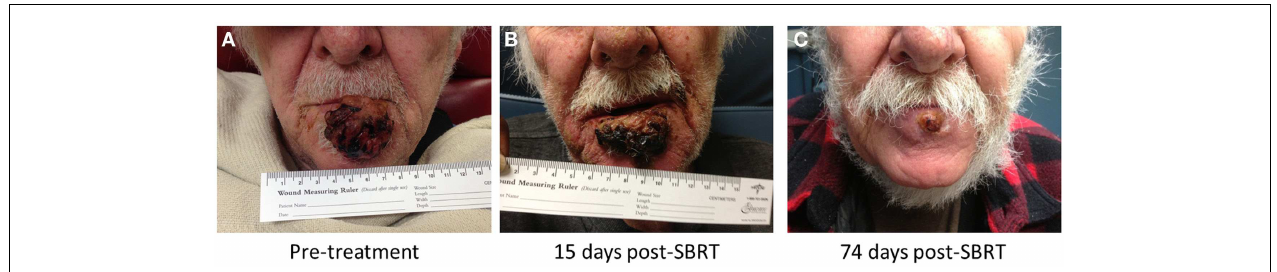
FIGURE 2 | Our patient with squamous cell carcinoma involving the lower lip, before treatment (A), 15days (B), and 74days (C) post-treatment